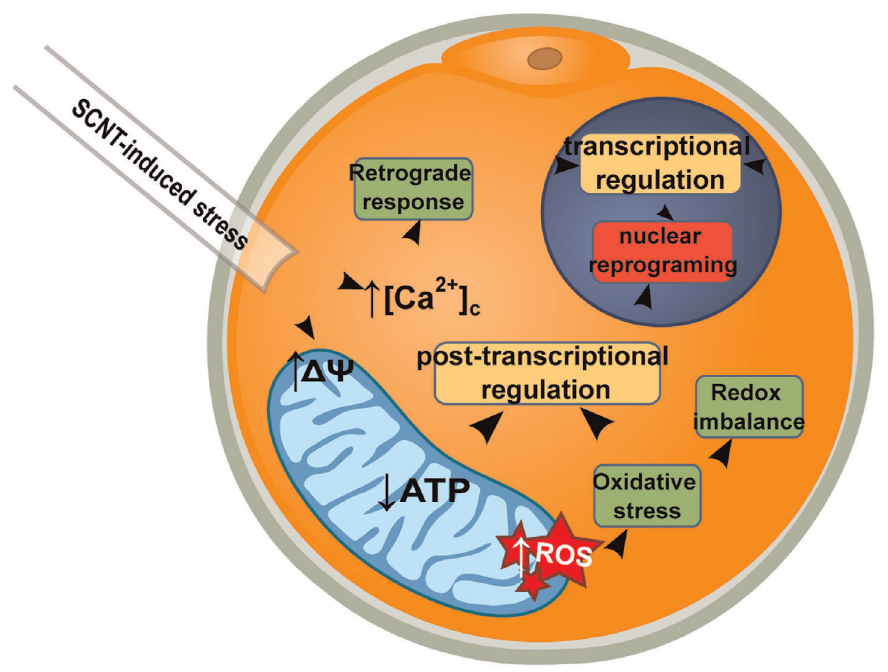
Figure 7. Model of post-transcriptional regulation after SCNT. Interlinked events at the metabolic level, disturbed after SCNT, are proposed to impact on reprogramming and embryo development outcome. SCNT manipulation alters mitochondrial membrane potential ( Dy ), triggers cytosolic Ca 2 + concentration ([Ca 2 + ] c ) increase, ATP decrease and reactive oxygen species (ROS) increase. Increased cytosolic Ca 2 + -induced retrograde response, and ROS-induced redox imbalance, could induce transcriptional regulation. Oxidative stress and decreased ATP could induce cellular responses driving post-transcriptional regulation. Proposed effects could be direct (bold arrows), or follow after a cascade of events (indirect; dashed